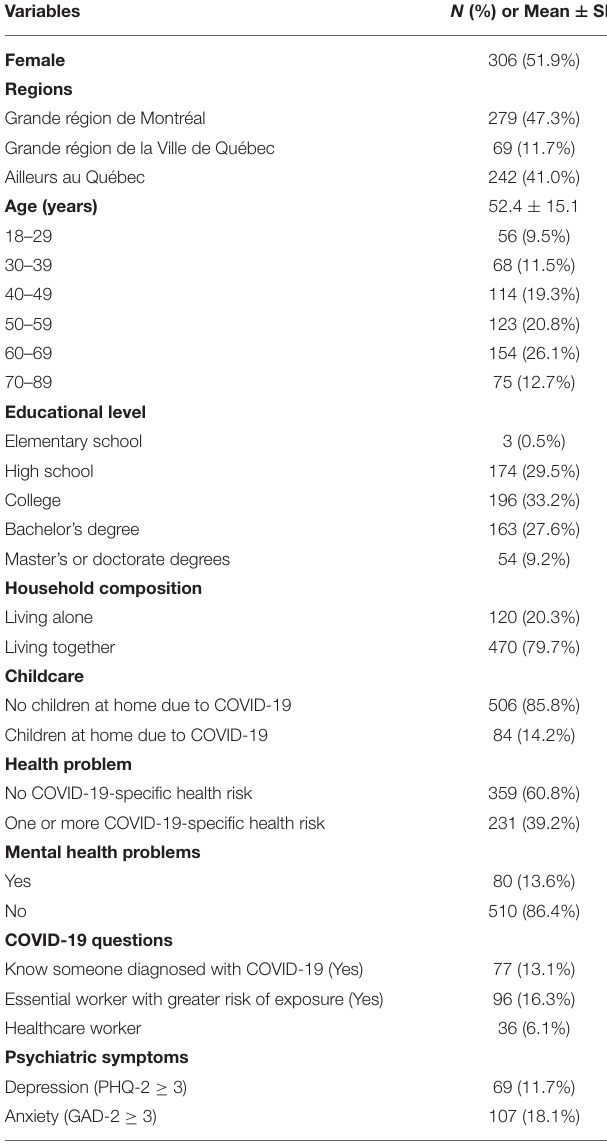
TABLE 1 | Demographic characteristics of the participants ( N =